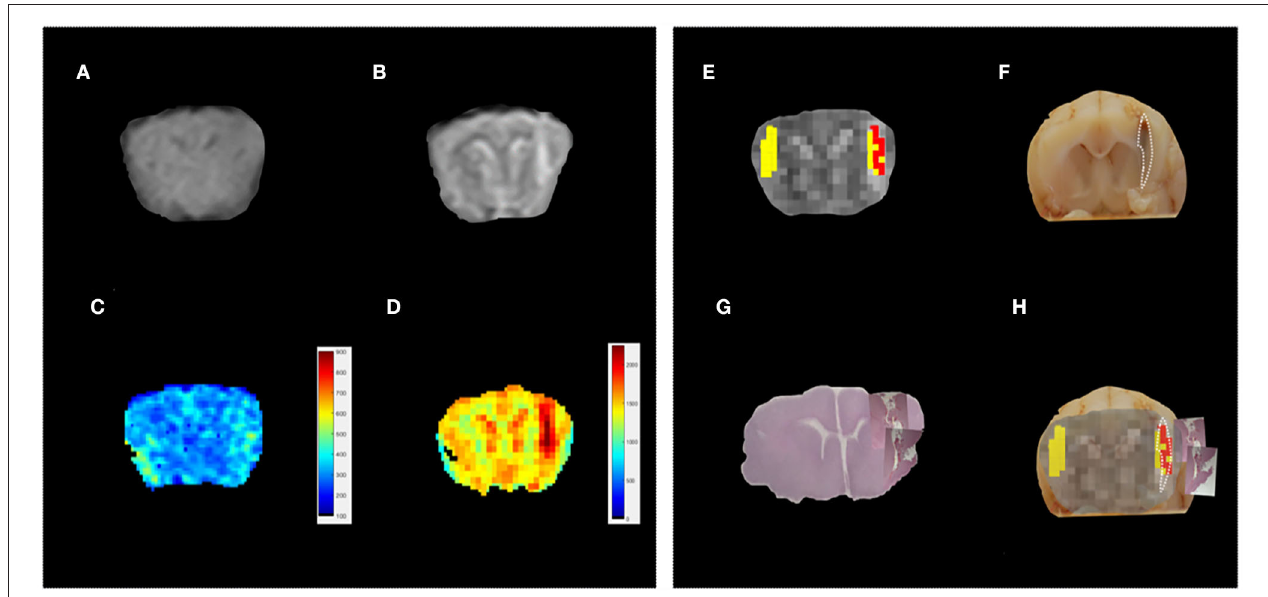
FIGURE 3 | Standard vs. MRR analyses and histopathological validation. Example 2. In all panels, the left-brain hemisphere is on the right part of the image. (A) T1w transverse image of the brain; the lesion has been judged “not visible” by a board-certified radiologist. (B) T2w transverse image of the brain. Also, in this case, the lesion appears ill-defined, hyperintense, and linearly shaped in the Nucleus Caudatus (white arrow), (C,D) T1 and T2 maps, respectively. A hyperintense linear-shaped area is visible in both maps (white arrow), (E) The output of the hierarchical cluster overlaid on the T2 map. Voxels classified as “pathological” and “healthy” parenchyma are reported in red and yellow, respectively. (F) the results of gross anatomy. From the photograph of the brain section, the contour of the hemorrhagic lesion characterized by a linear shape that involves the left frontal lobe (white arrow) has been delineated (white dotted line), (G) histopathology results. The overall brain section obtained from the microscope with the hemorrhagic lesion shown in greater detail superimposed on the overall section is reported, and (H) a good agreement can be noted between the MRR classification and the lesion contour estimated from both gross anatomy and